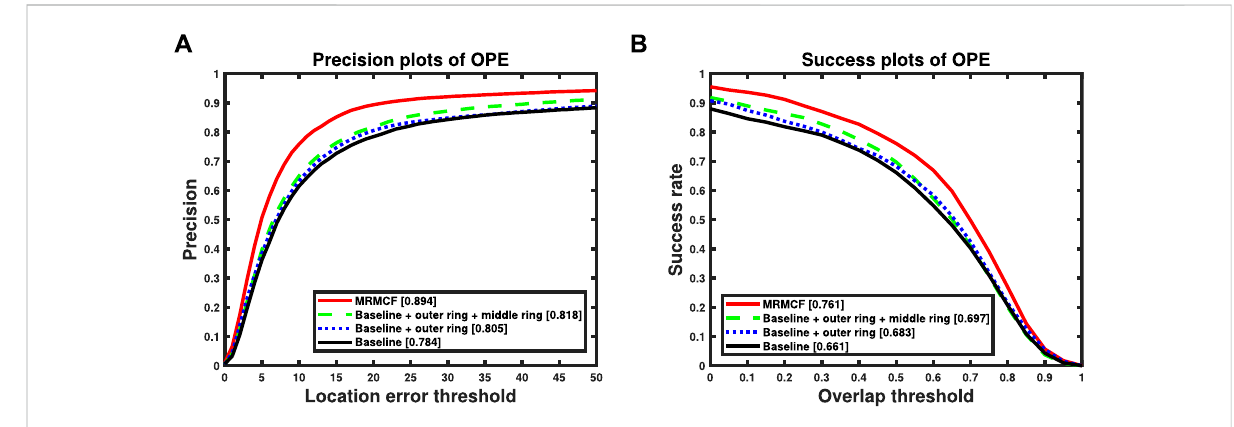
FIGURE 6 OPE comparison results of trackers with different con fi guration MRM models on OTB50. (A) Precision plots, (B) Success